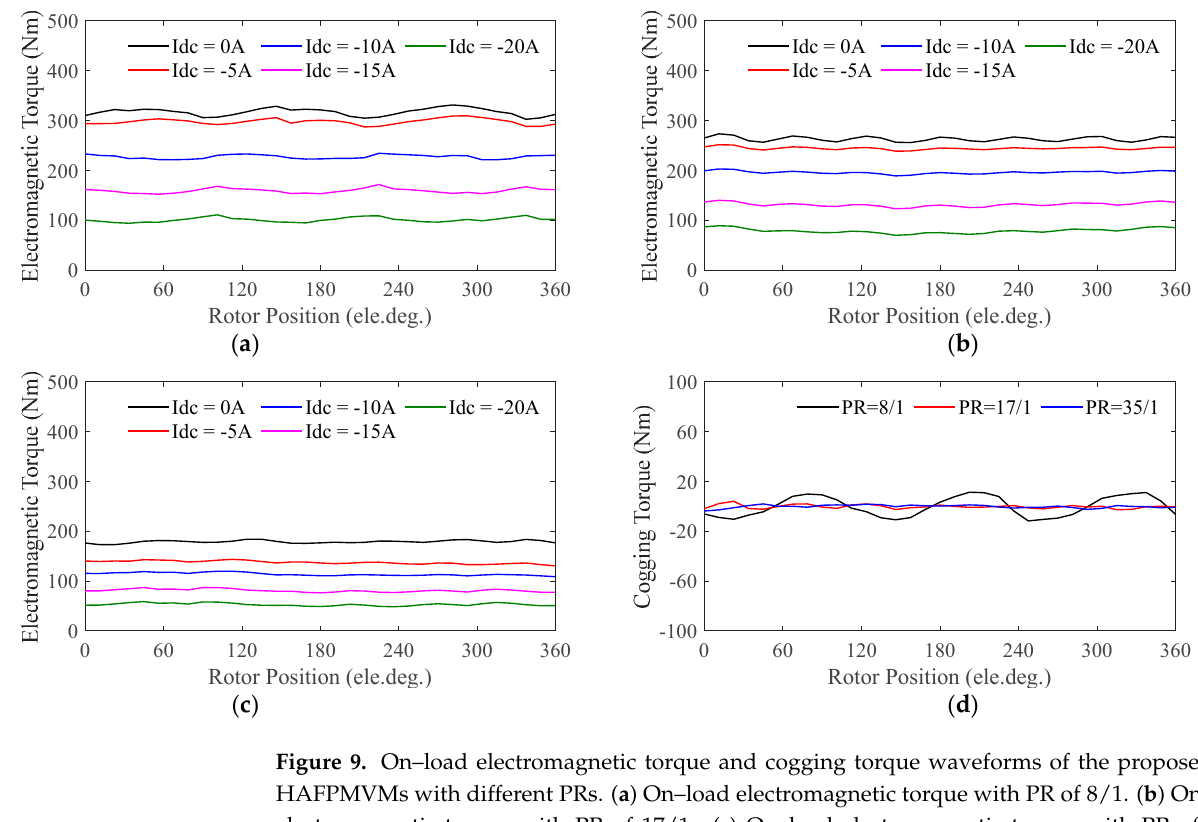
Rotor Position (ele.deg.)